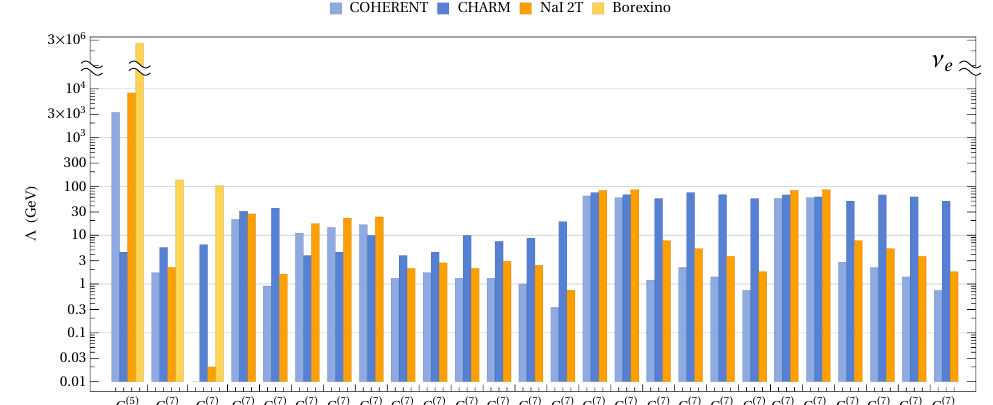
Figure 16.2: Limits from COHERENT, CHARM, Borexino, and projected limits from a NaI 2T experiment on the scale Λ of dimension 5 and dimension 7 NSI operators for electron